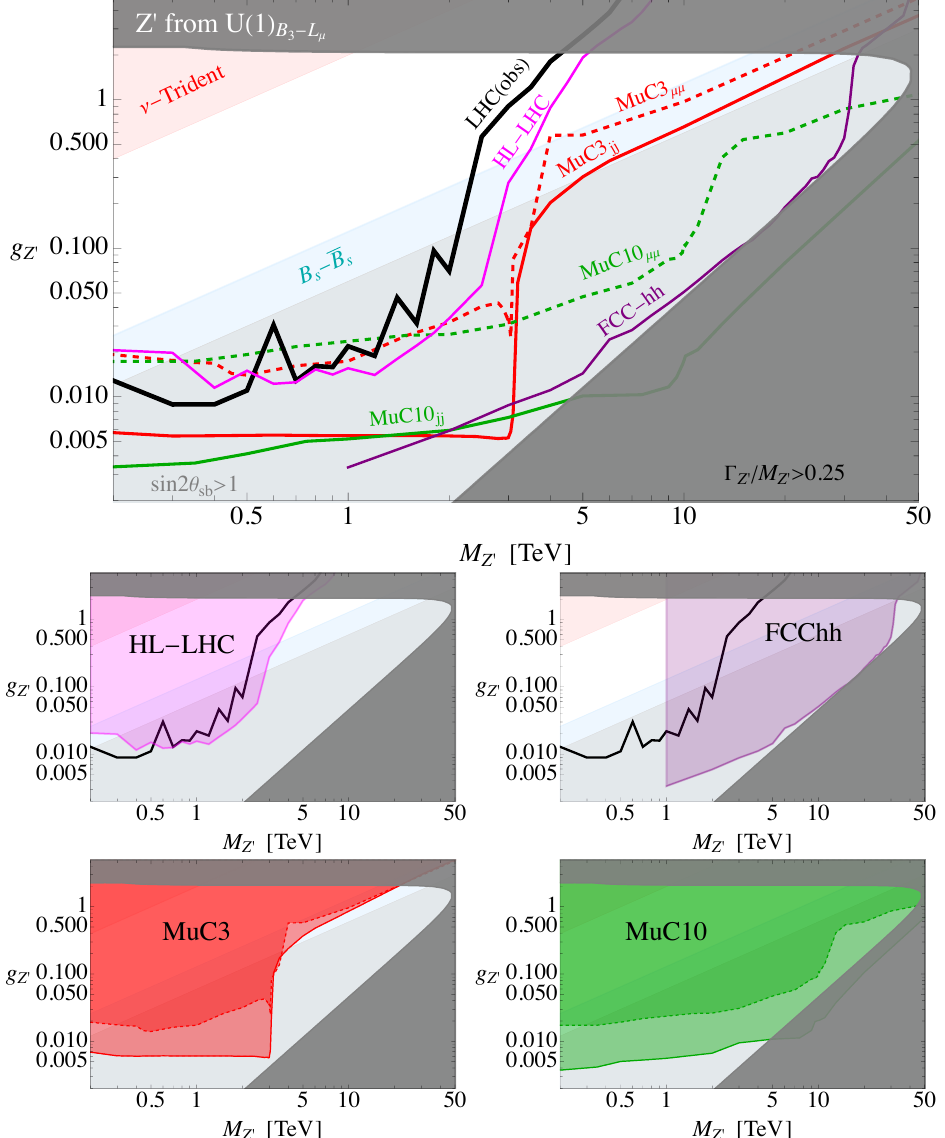
Figure 10 . Discovery reach at 5 σ for the B 3 − L µ model. The fit to bsµµ anomalies is imposed everywhere, eq. (5.4). The region excluded at 95% CL by LHC [88] is above the black line, while the one excluded by B s mixing is colored in light blue. The light gray region cannot provide a successful fit to b → sµµ anomalies for values of sin 2 θ sb < 1 , eq. (5.4), while in the dark gray region the Z 0 has a large width, signaling a loss of perturbativity. The discoverable region at future colliders is the one on the side of the line where the corresponding label has been drawn. The smaller figures below the main figure highlight a single future collider at a